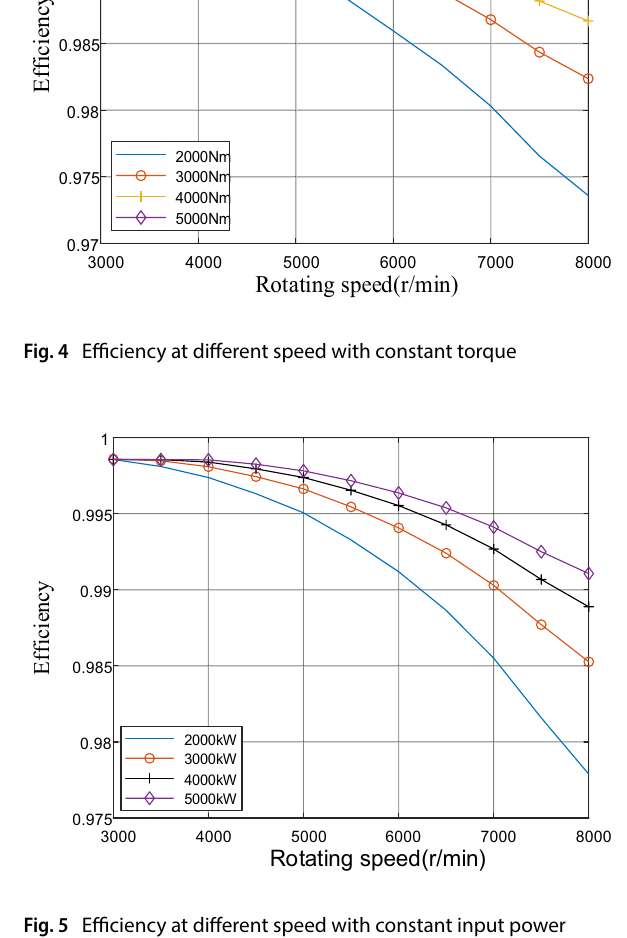
Fig. 5 Efficiency at different speed with constant input power